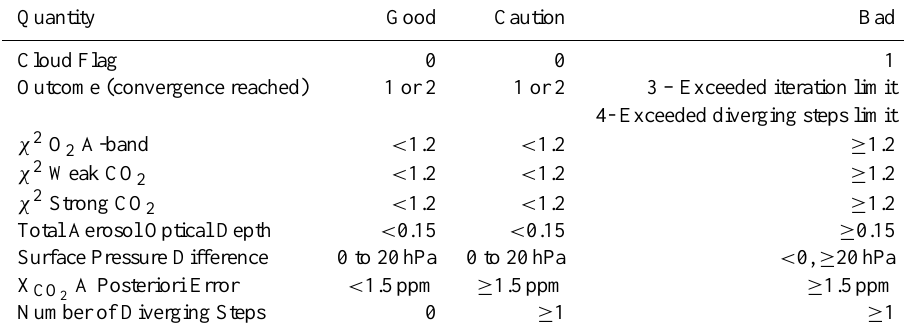
Table 4. Retrieval Validity Criteria for B2.8. Quantity Good Caution Bad Cloud